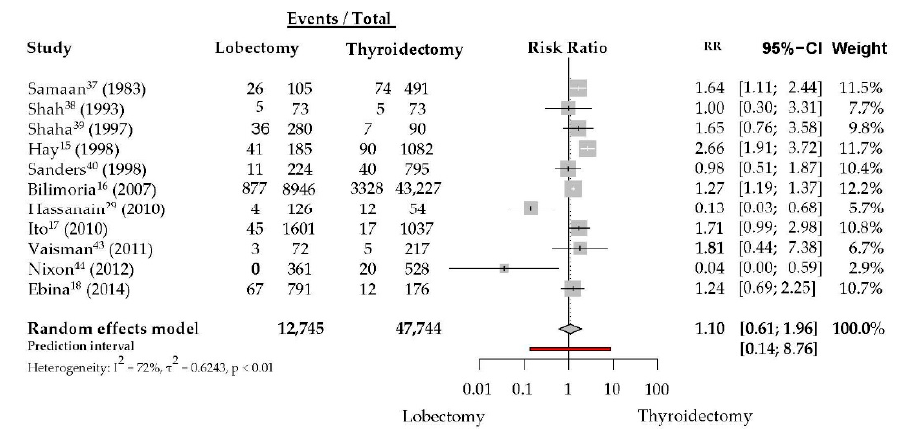
Figure 2. Recurrence rates of di ff erentiated thyroid carcinoma after total thyroidectomy versus